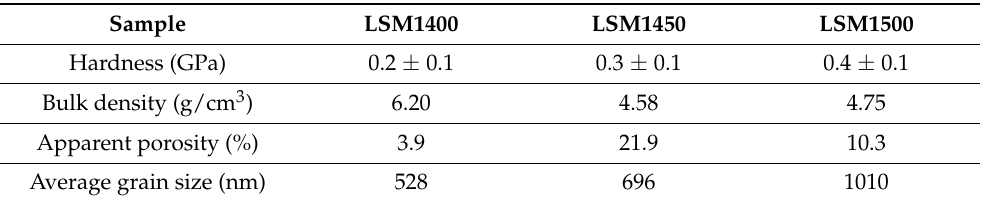
Table 3. Mechanical and physical properties of La 0.6 Sr 0.4 MnO 3 samples obtained at different calcina- tion